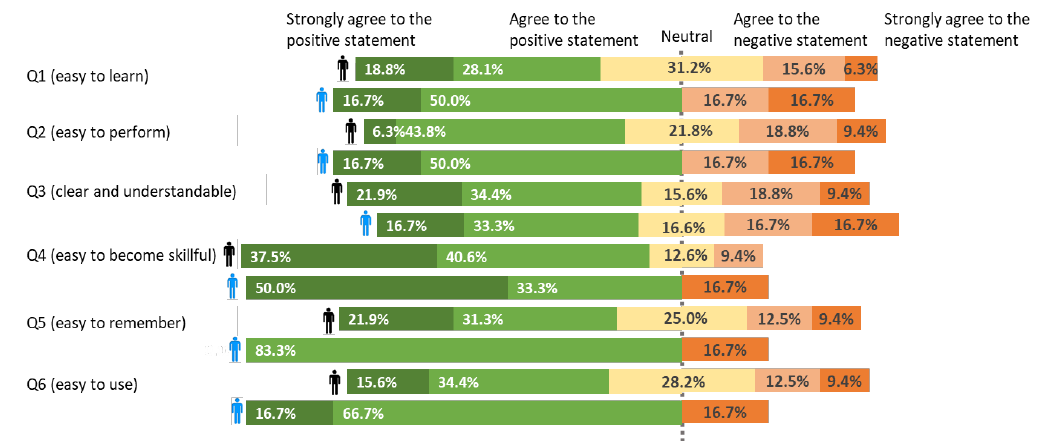
Fig. 14. Perceived ease of use of USINN for interaction and navigation